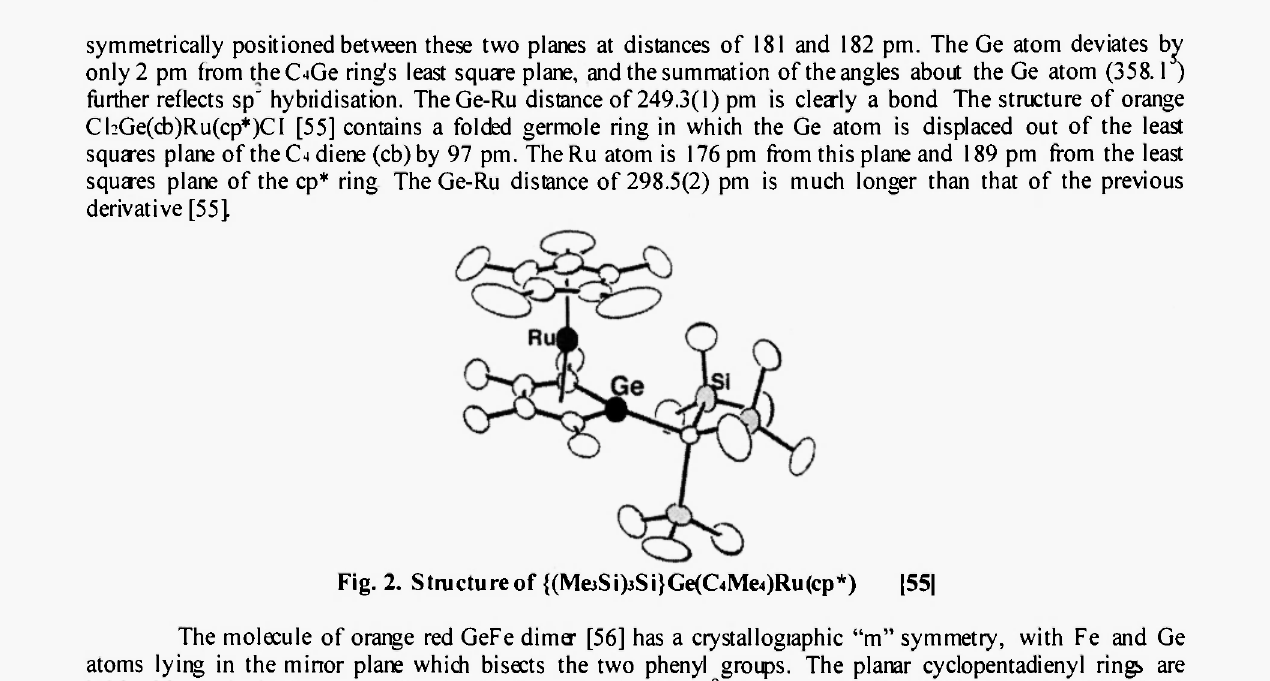
Fig. 2. Structure of {(MejSi>Si}Ge(C4Me4)Ru(cp*)